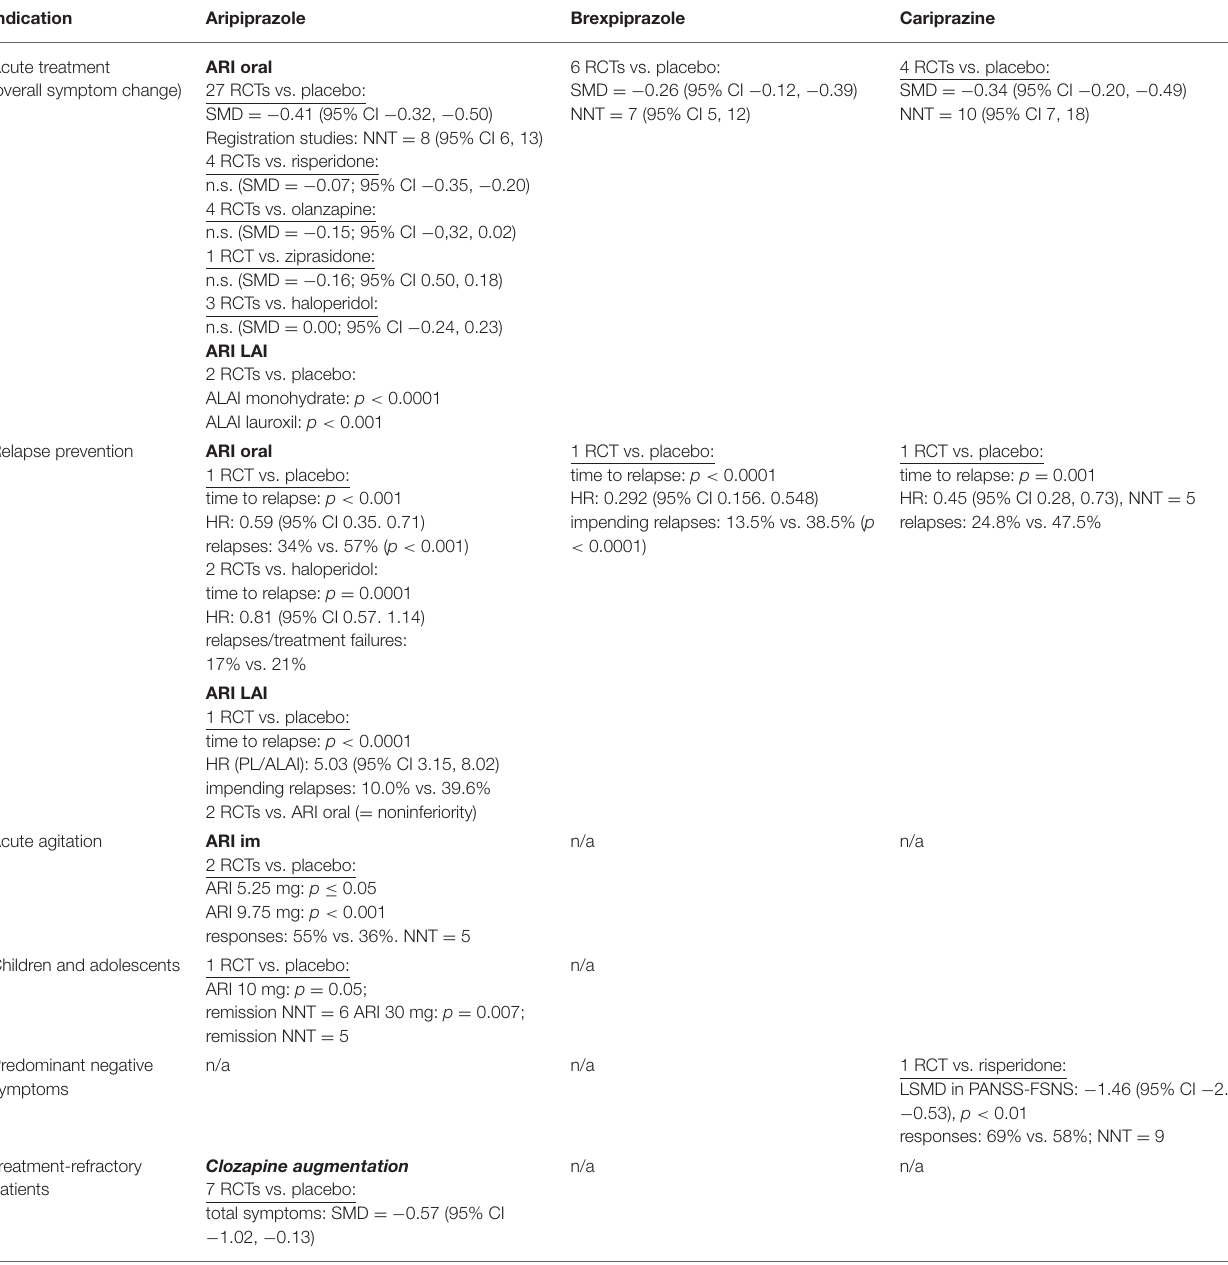
TABLE 2 | Randomized double-blind trials of DRPAs in schizophrenia. Indication Aripiprazole Brexpiprazole Cariprazine Acute treatment ARI oral (overall symptom change) 27 RCTs vs. placebo: